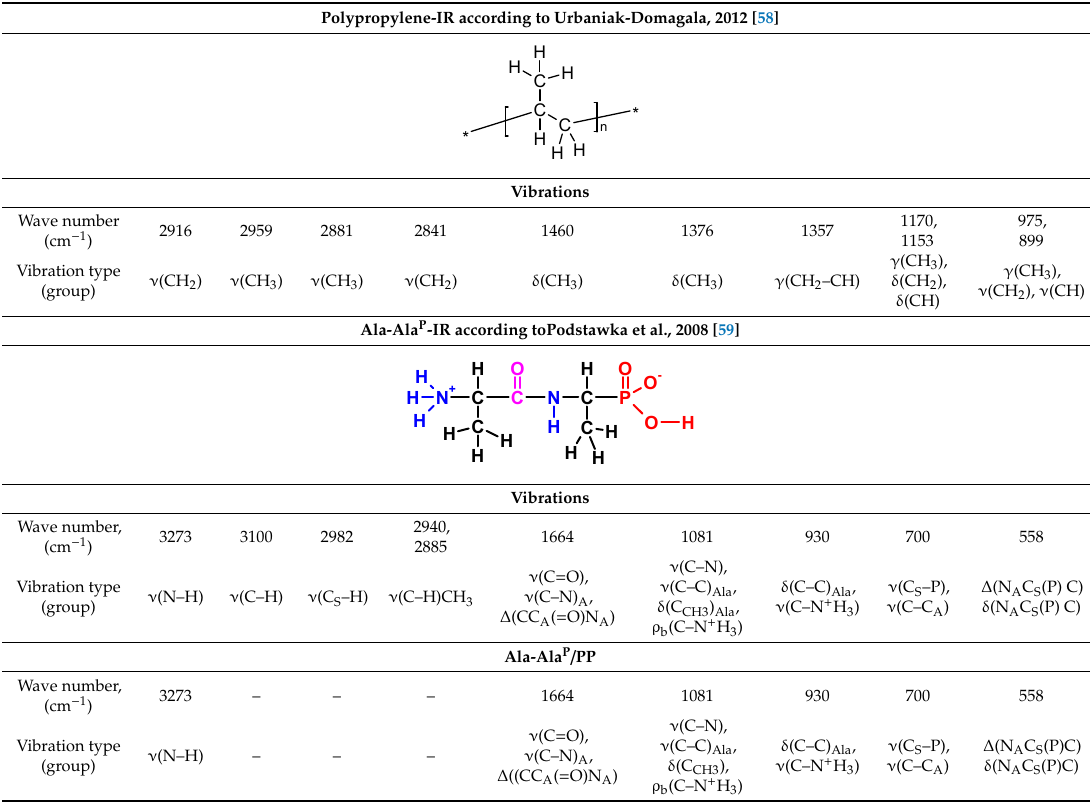
Figure 4. Comparison of transmittance spectra (%T) in the range λ = 200–800 nm of polypropylene nonwoven samples without (PP) and with L-Ala-Ala P modifier (PP-MOD). 3.4. Technical